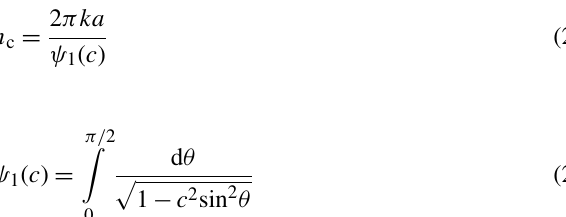
Figure 7. Calculation flow chart of ball bearing